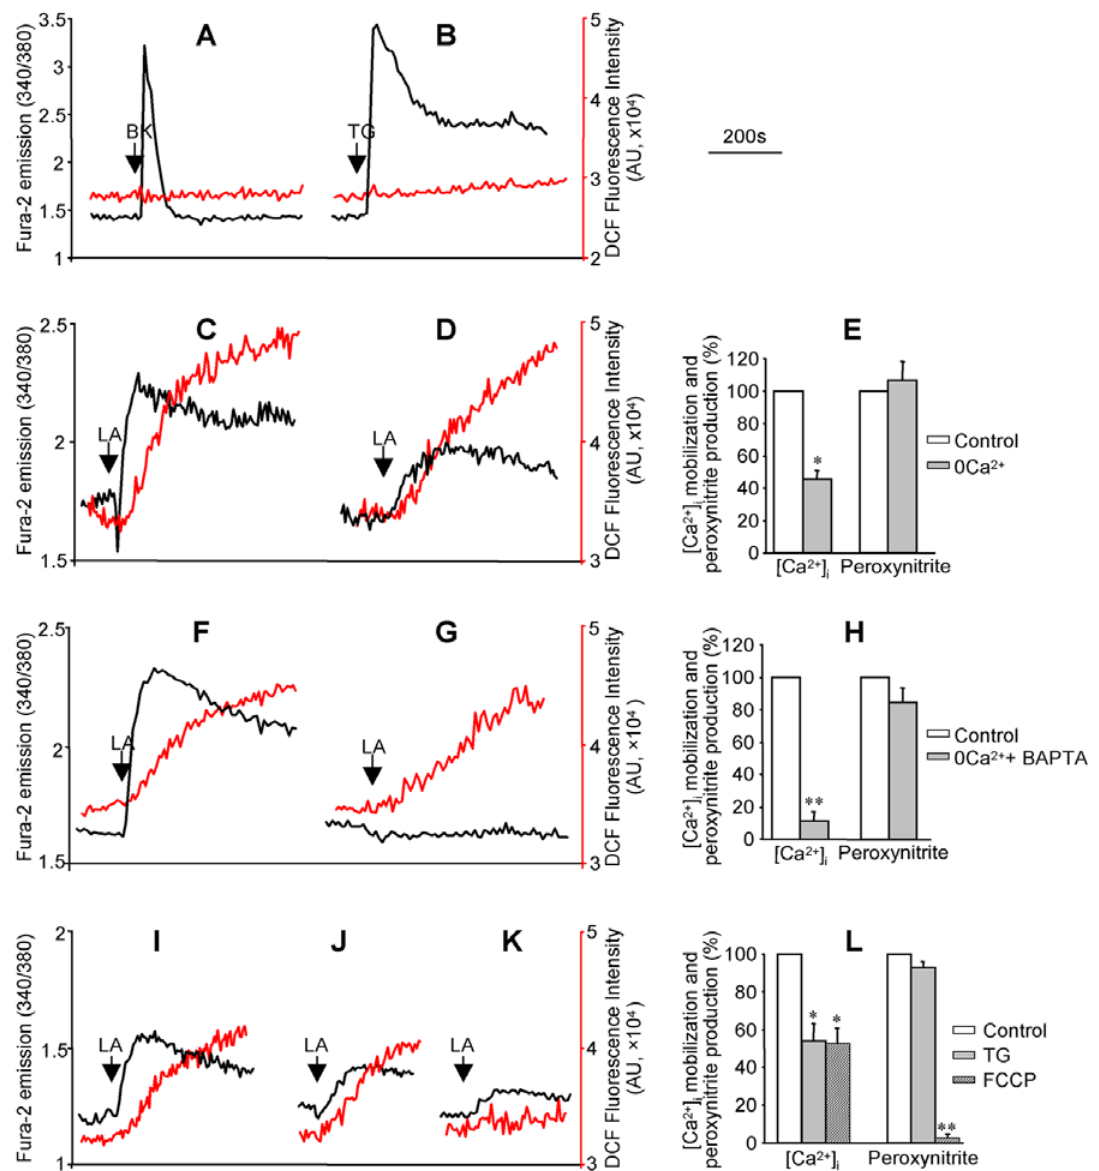
Figure 3. Mitochondria played an essential role in LA-induced [Ca 2 + ] i mobilization and peroxynitrite generation. HM cells were labeled with fura-2 and DCF to measure [Ca 2 + ] i mobilization (black traces) and peroxynitrite generation (red traces). (A): Bradykinin (BK, 100 nM) responses; (B): thapsigargin (TG, 2 m M) responses; (C) and (F): LA responses measured in the presence of extracellular Ca 2 + (control); (D): LA responses measured without extracellular Ca 2 + ; (G) LA responses measured in cells pretreated with BAPTA (50 m M, 30 min) without extracellular Ca 2 + . In the absence of extracellular Ca 2 + , (I): LA responses (control); (J): LA responses in cells pretreated with TG (2 m M, 5 min); (K) LA responses in cells pretreated with FCCP (a mitochondrial uncoupler; 4 m M, 5 min). The values in graphs (E, H, and L) represent the mean 6 SEM of the relative amplitudes of